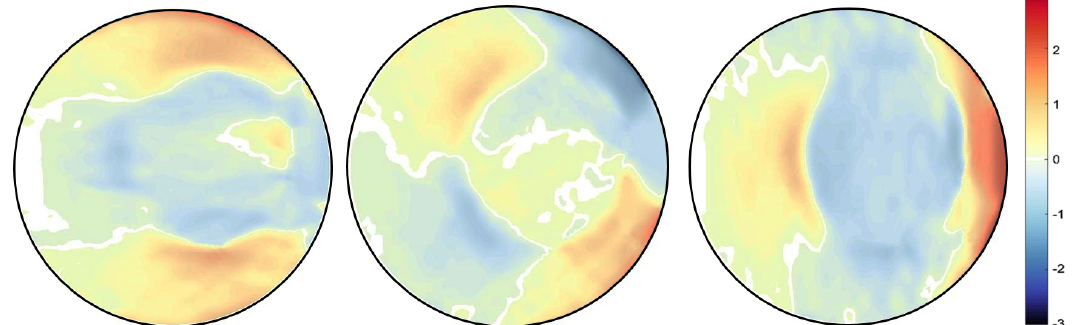
Figure 13. Regularised strain field ε xx , ε xy , ε yy respectively for structured mesh type, with S as stiffness matrix and α =